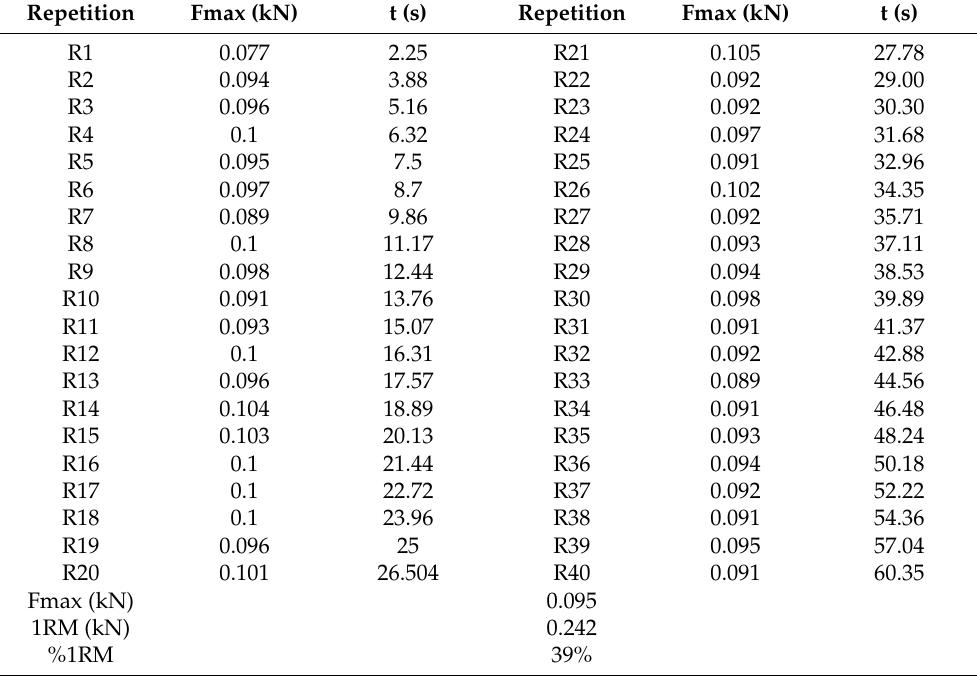
Table 4. Maximum forces per repetition—5 kg machine